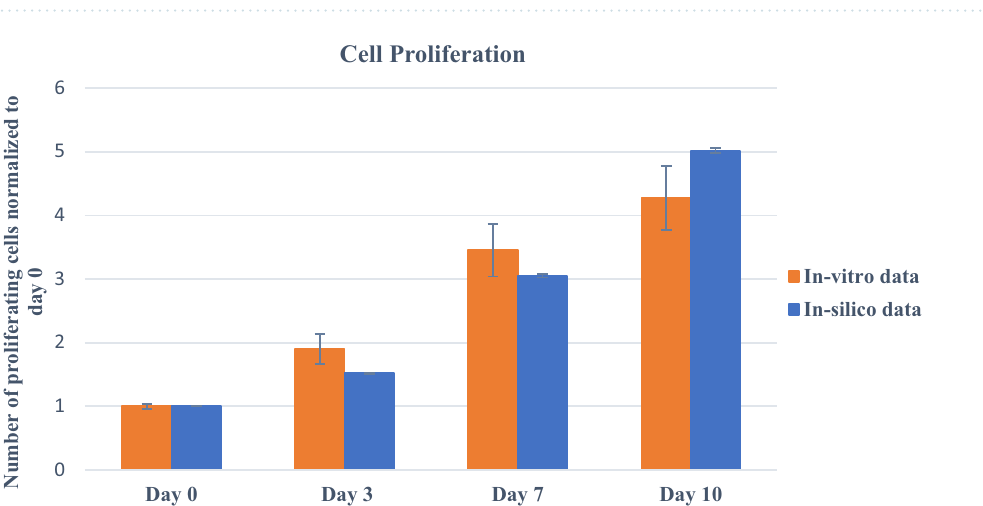
Figure 7. Prediction of cell proliferation using in-silico model for case 1: 1.5 × 1 0 4% gelatin/4% alginate bioink; on day 0, 3, 7, and 10. In vitro study was performed using the MTT assay. Error bars represent ± SD, n ≥